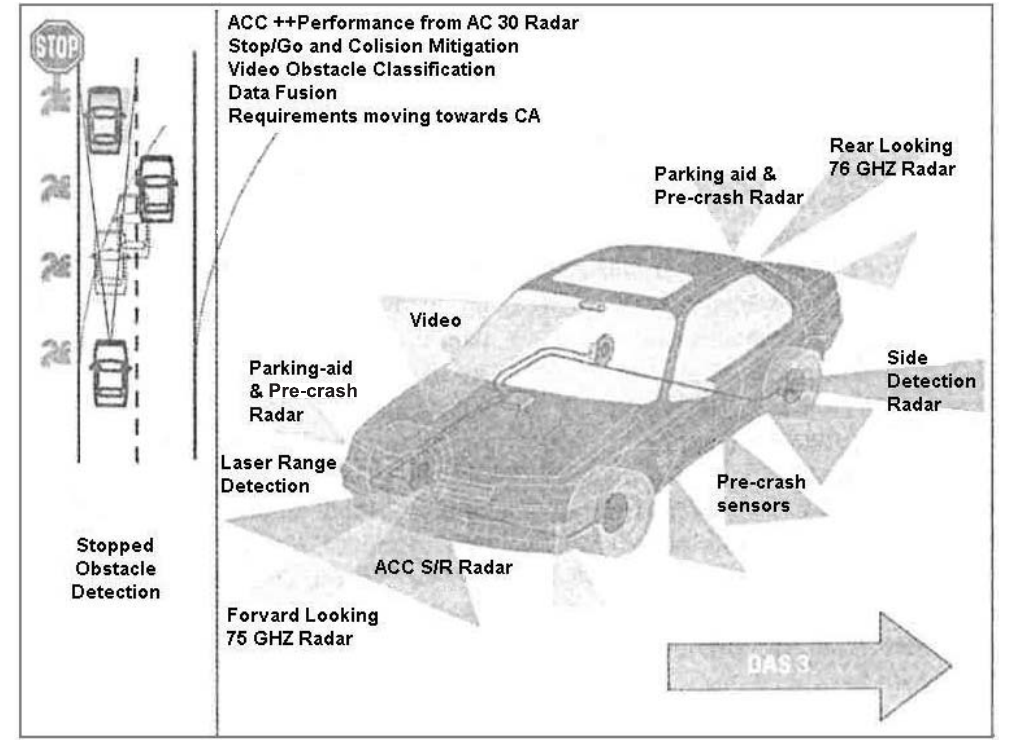
Fig. 6. Driver assistance